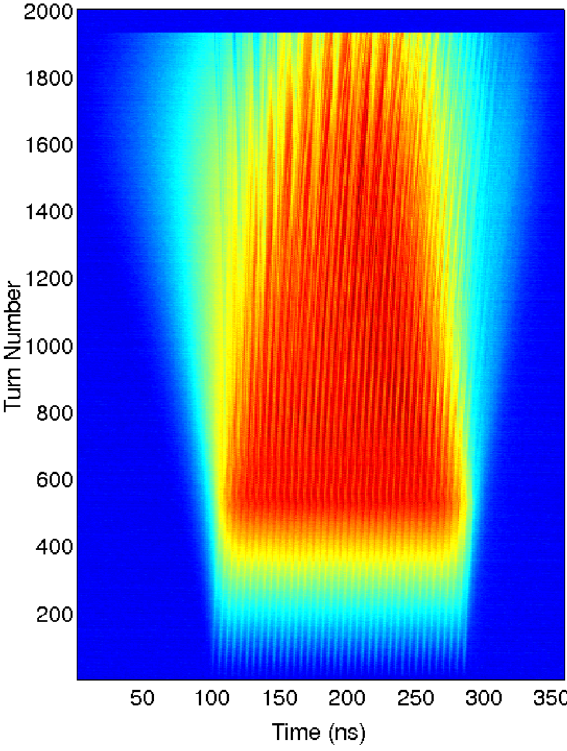
1. (Color) Waterfall plot of the wall current monitor signal for the chopped beam experiment. The time in a single pulse is plotted on the horizontal axis, and the turn number is plotted on the vertical axis. Beam injection ends at 559 turns. The high frequency variations in color indicate the microbunch structure of the beam. The beam gap region is displayed in